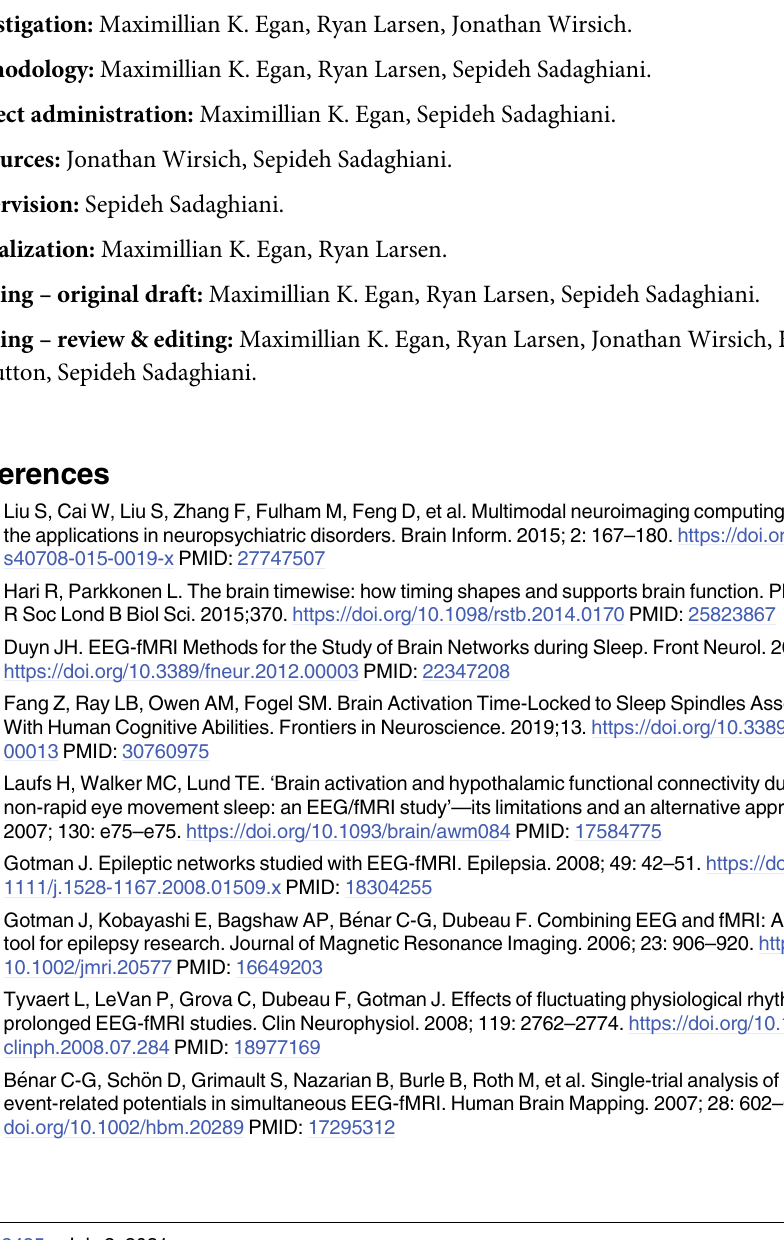
occipital object-specific areas